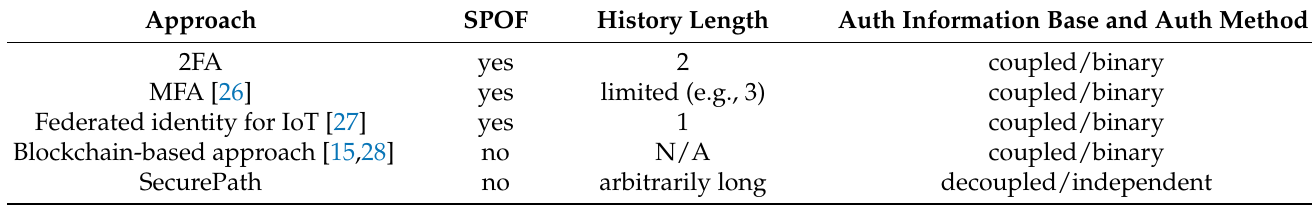
Table 1. Comparison of different authentication